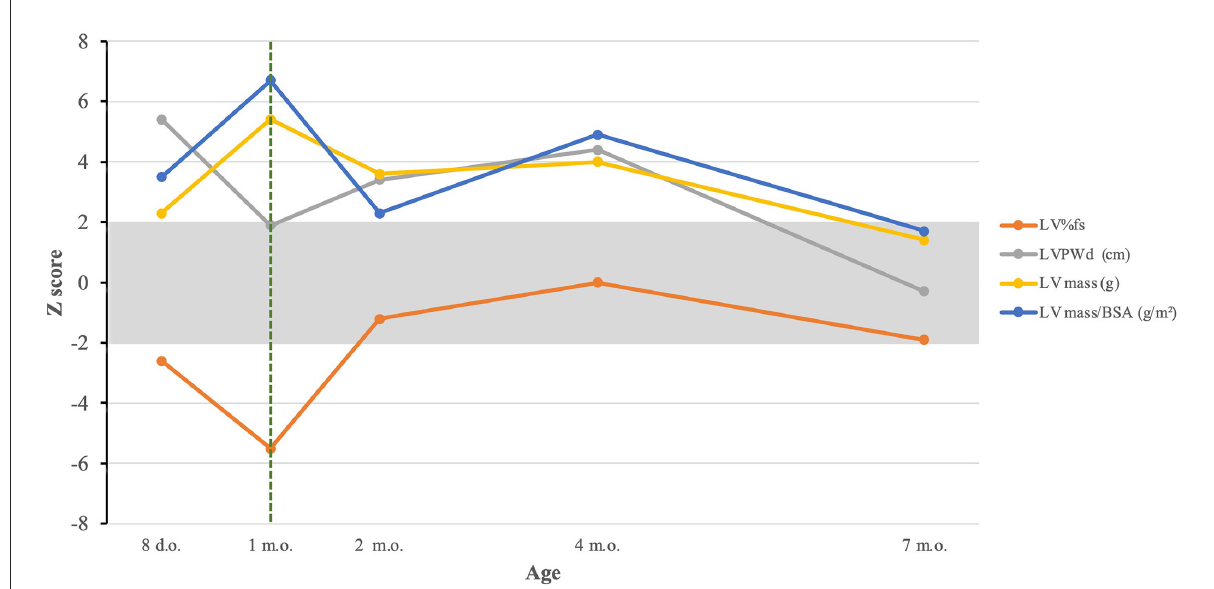
FIGURE2 Evolution of cardiac indices in response to treatment. The dashed green line represents initiation of ERT. LV%fs, left ventricular percentual fractional shortening; LVPWd, left ventricular posterior wall dimension; LV mass, left ventricular mass; LV mass/BSA, left ventricular mass/body surface